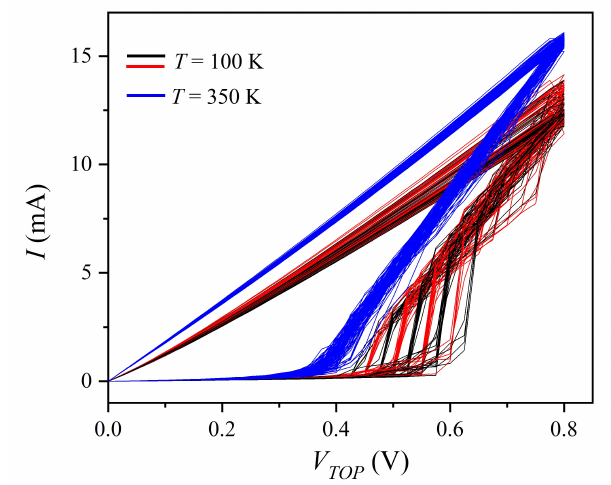
Figure 8. I–V curves at positive voltages for T = 100 K (red and black lines) and T = 350 K (blue lines).